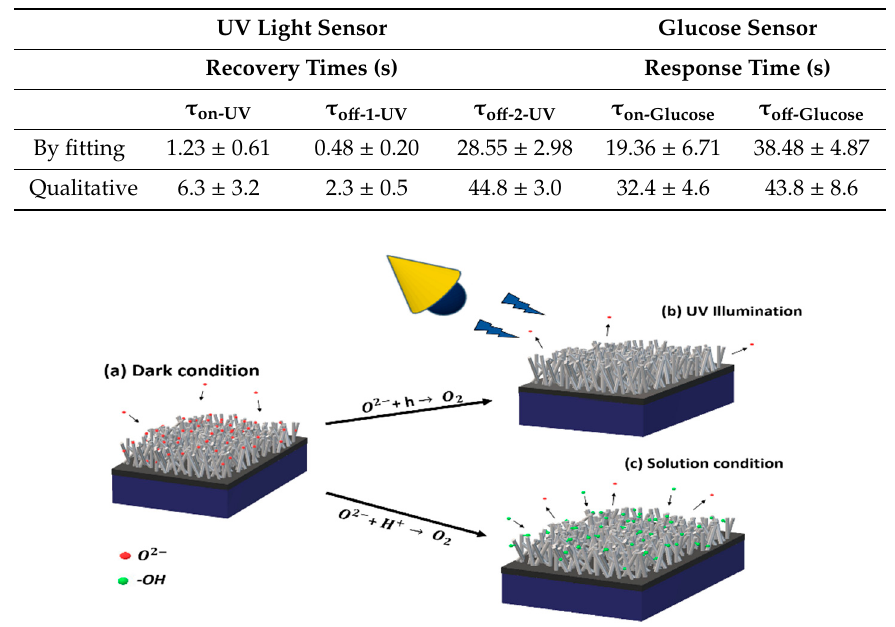
Figure 6. Response bar-graph of device based SnO 2 nanowire sensor in four different settings: only nanowire (NW-dev); under UV (UV); combined effect between UV light and 1 mole of GLU (UV + Glucose) and under 1 mole of GLU (Glucose). For both UV light and GLU, the transduction process occurred through the release of electrons, changing the conductive material conductivity. However, the sensor exposure to the combined effect